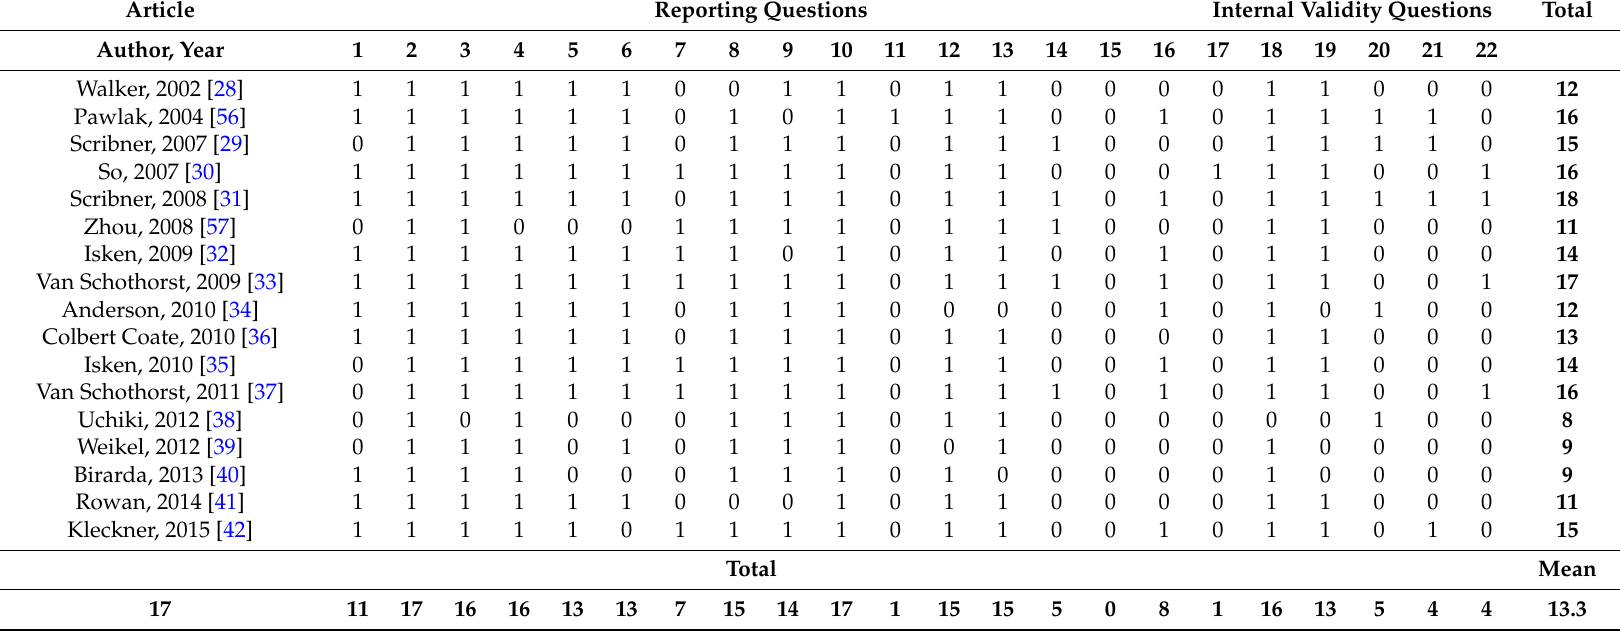
Table 6. Mouse Methodological Quality Assessment. Each article using mice was given a score of 0 or 1 for each question. MQA, methodological quality